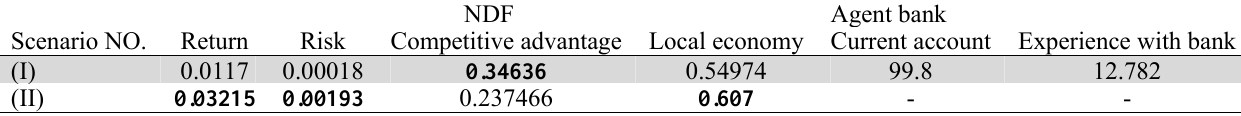
Different objective functions values for different scenarios NDF Agent bank Scenario NO. Return Risk Competitive advantage Local economy Current account Experience with bank